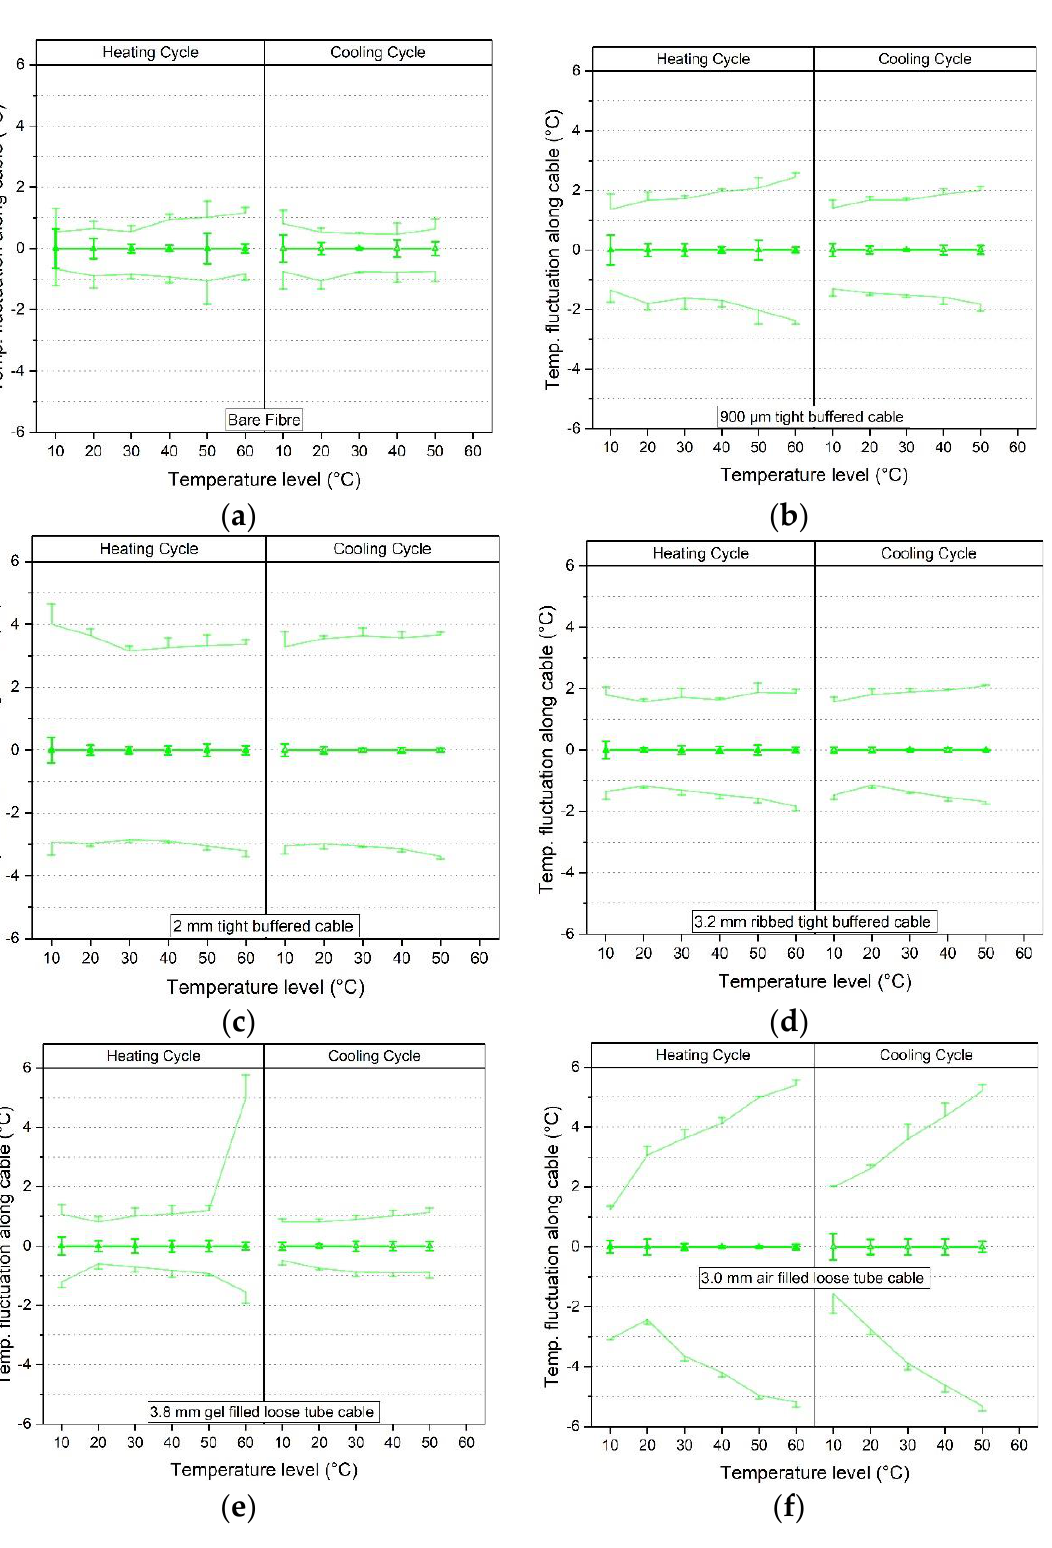
Figure 14. Temperature fluctuations along the fibre cable length evaluated at each temperature step for the third cycle for ( a ) bare fibre, ( b ) 900 μm tight buffered, ( c ) 2.0 mm tight buffered, ( d ) 3.2 mm ribbed tight buffered, ( e ) 3.8 mm gel filled loose tube and ( f ) 3.0 mm air filled loose tube cable.